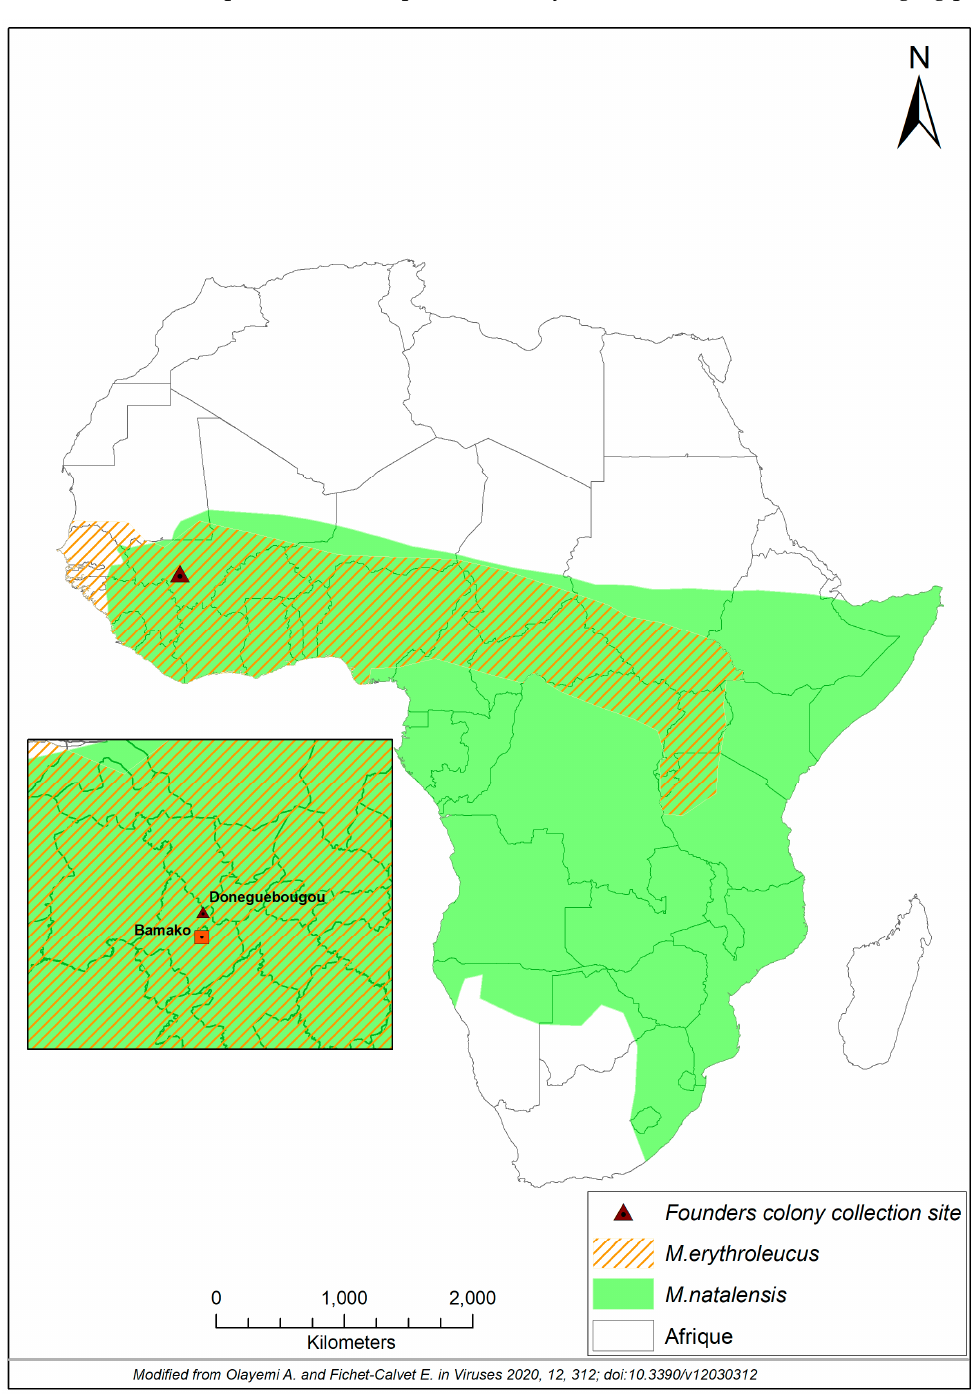
Figure 1. Geographic distribution of Mastomys natalensis and Mastomys erythroleucus in sub-Saharan Africa. Shown are the distributions of M. natalensis (shaded green) and M. erythroleucus (red-hatched) across sub-Saharan Africa. Inset denotes the village of Doneguebougou (triangle), where the founder rodents for the colony were live-trapped, in relation to the capital city of Bamako,